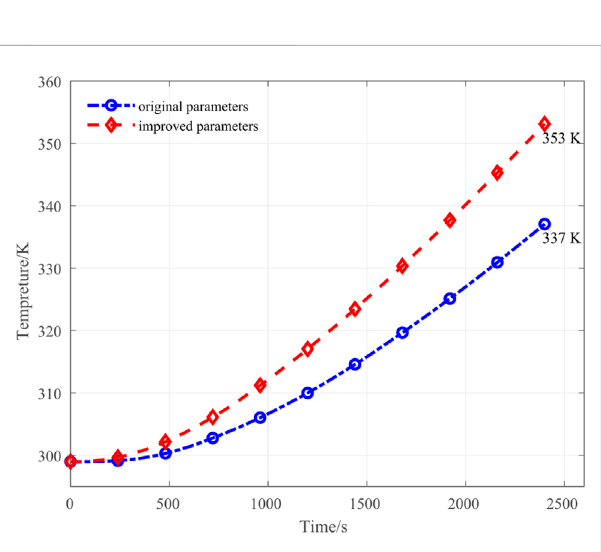
FIGURE 16 Lowest temperature in the drying cabinet for the basic con fi guration and optimized con fi guration as a function of simulation